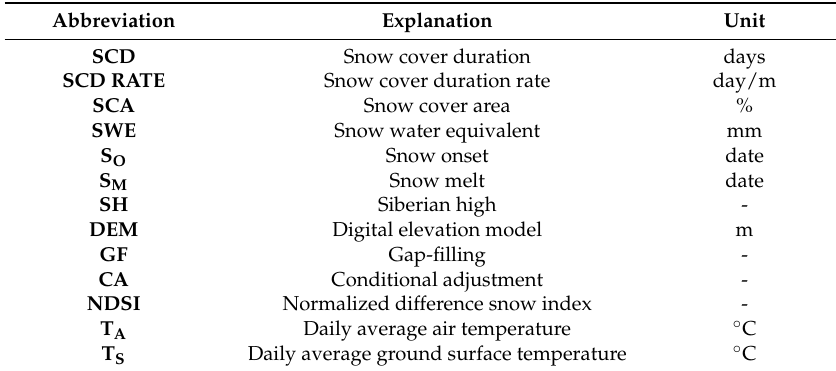
Table A1. Abbreviations used in the paper and their